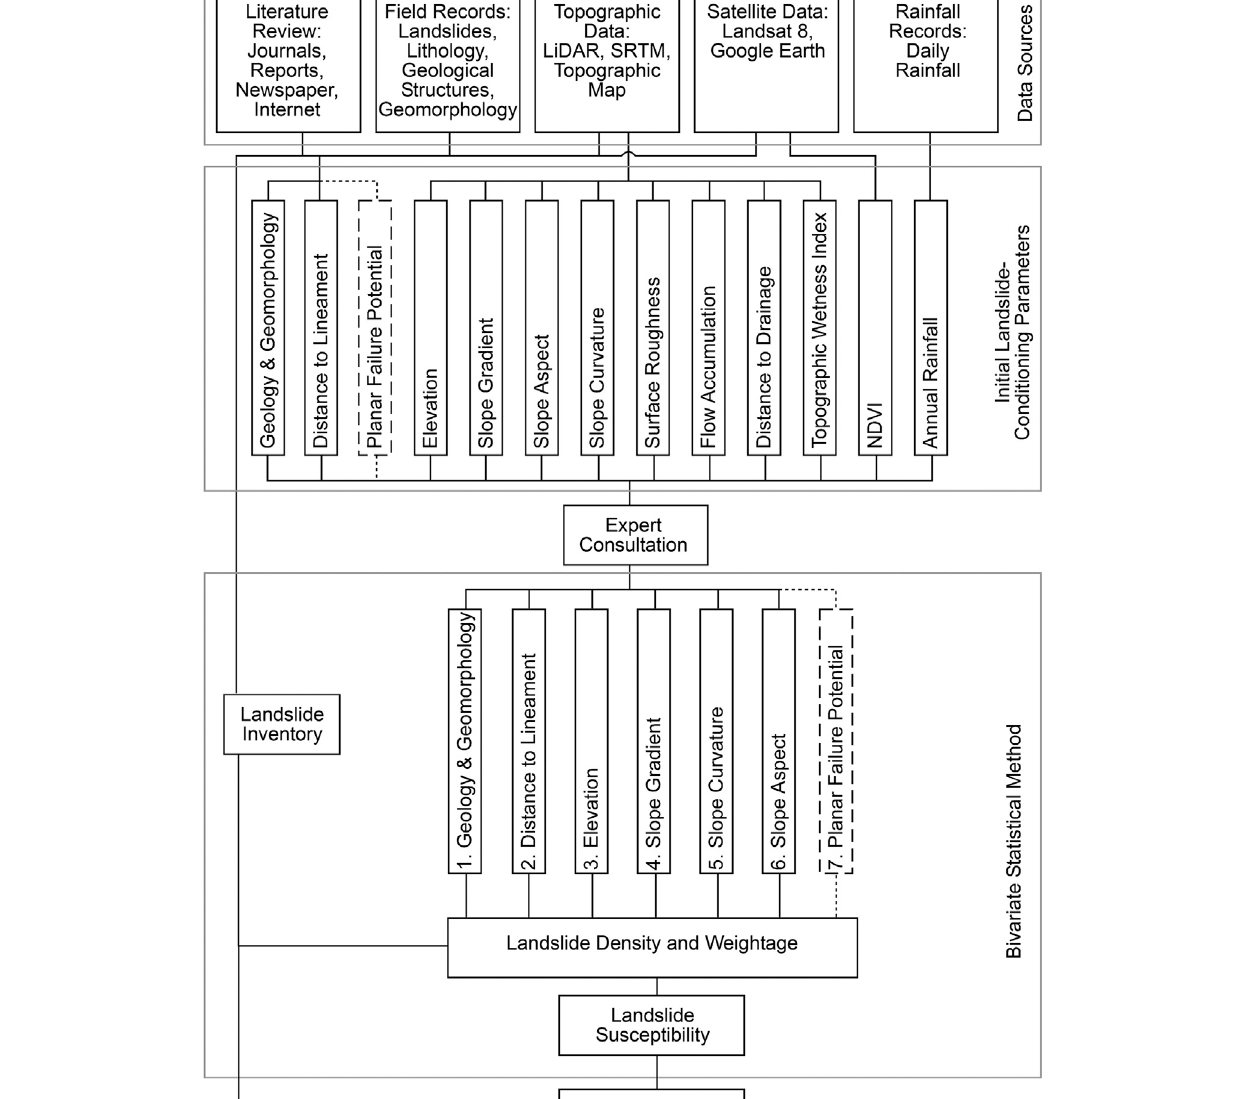
Frontiers in Earth Science |